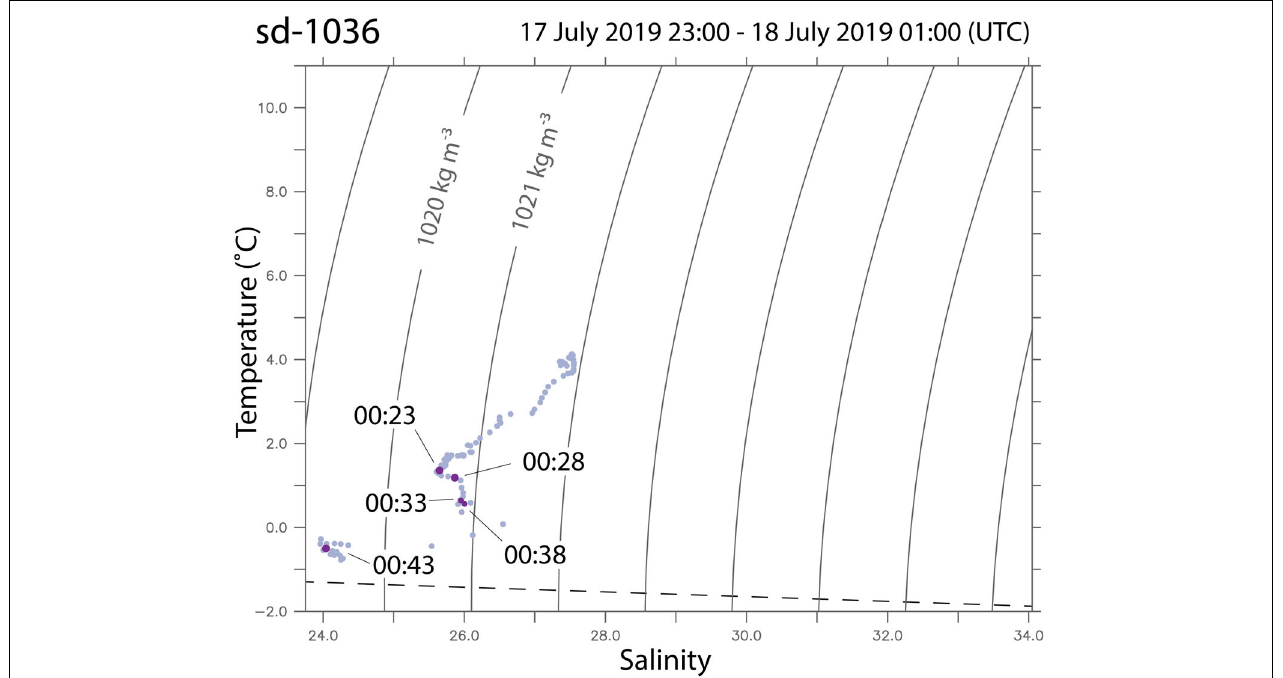
FIGURE 11 | One-minute average temperature and salinity measurements during sd-1036’s initial northward transect into an ice band on 18 July 2019. Density contours every 1 kg m - 3 (solid lines). Seawater freezing temperature calculated based on the equation suggested by Millero and Leung (1976) and used by Fofonoff and Millard (1983) is shown with a dashed line.